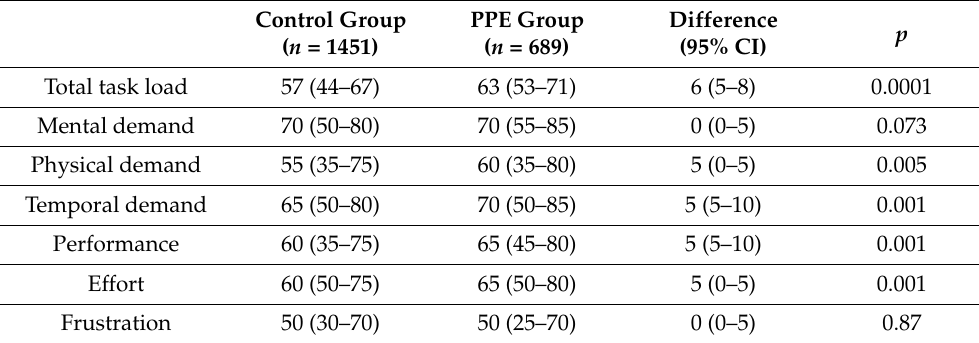
Table 3. NASA task load index questionnaire